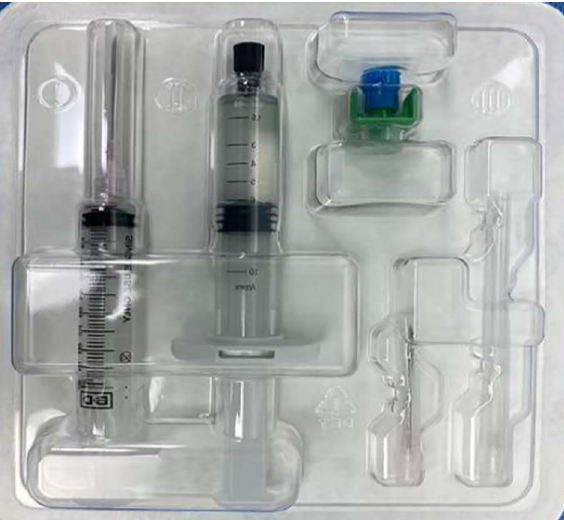
Figure 5. Gel package consisting of gel, connector, and empty syringe for